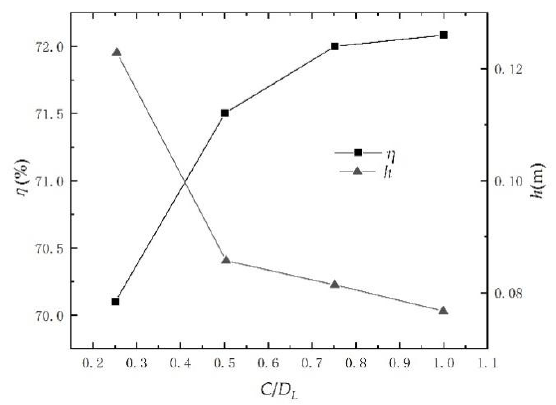
Figure 20. Pump system efficiency and hydraulic loss curve with different floor clearance.